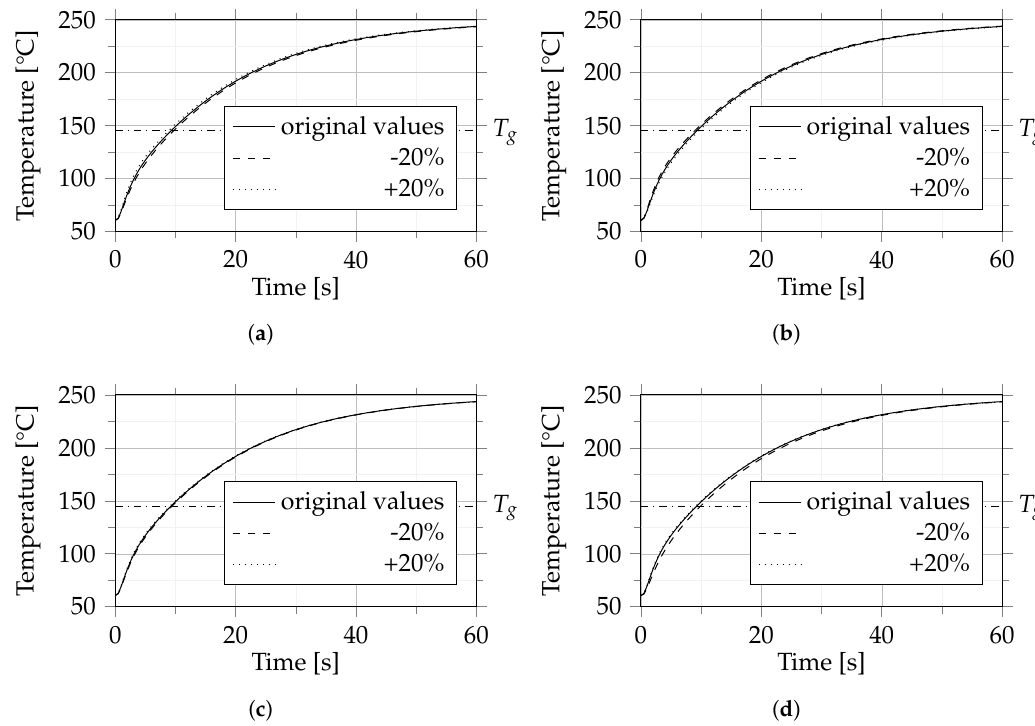
Figure 8. Temperature behavior of the considered composite during heating for various values of specific heat capacity of matrix c p , m ( a ), specific heat capacity of fiber c p , f ( b ), thermal conductivity of matrix λ m ( c ) and thermal conductivity of fiber λ f ( d ). The dash-dotted line indicates the glass transition temperature ( T g ) of 145 °C.